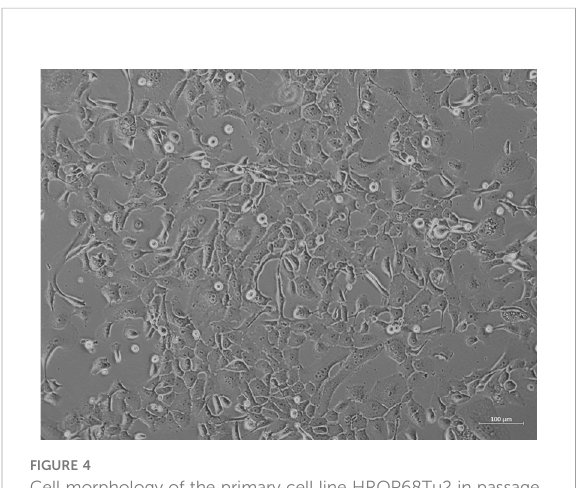
FIGURE 4 Cell morphology of the primary cell line HROP68Tu2 in passage 11. Picture was taken using an inverted microscope at ×40 magni fi